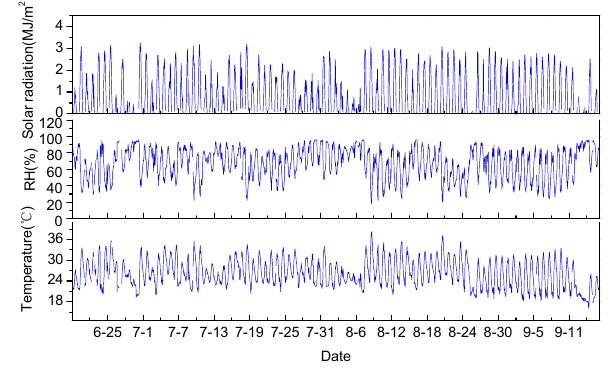
Fig. 2. Time series of hourly mean values of accumulative solar radiation, relative humidity and temperature at and temperature at BL 4